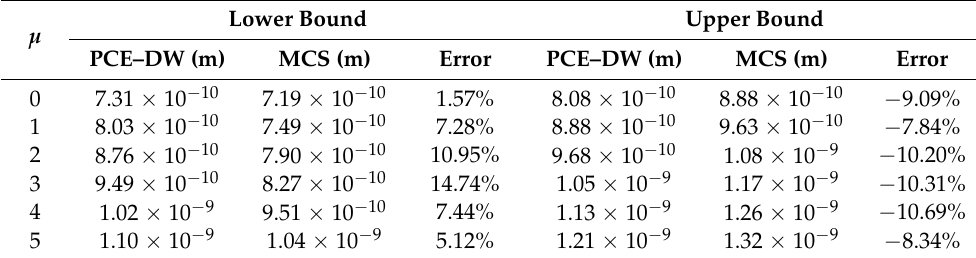
Table 8. The bounds of the variance calculated by PCE–DW and